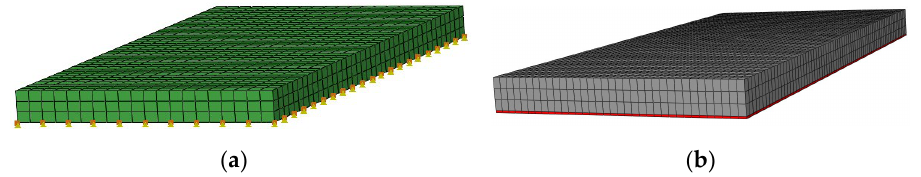
Figure 11. FE model of FST; the resilient mat was modelled by ( a ) Kelvin’s model and ( b ) 3PVM . According to the derivation in Section 2, the 3PVM can reflect the frequency variation characteristic of the elastic modulus of the mat. The storage modulus can be expressed as: